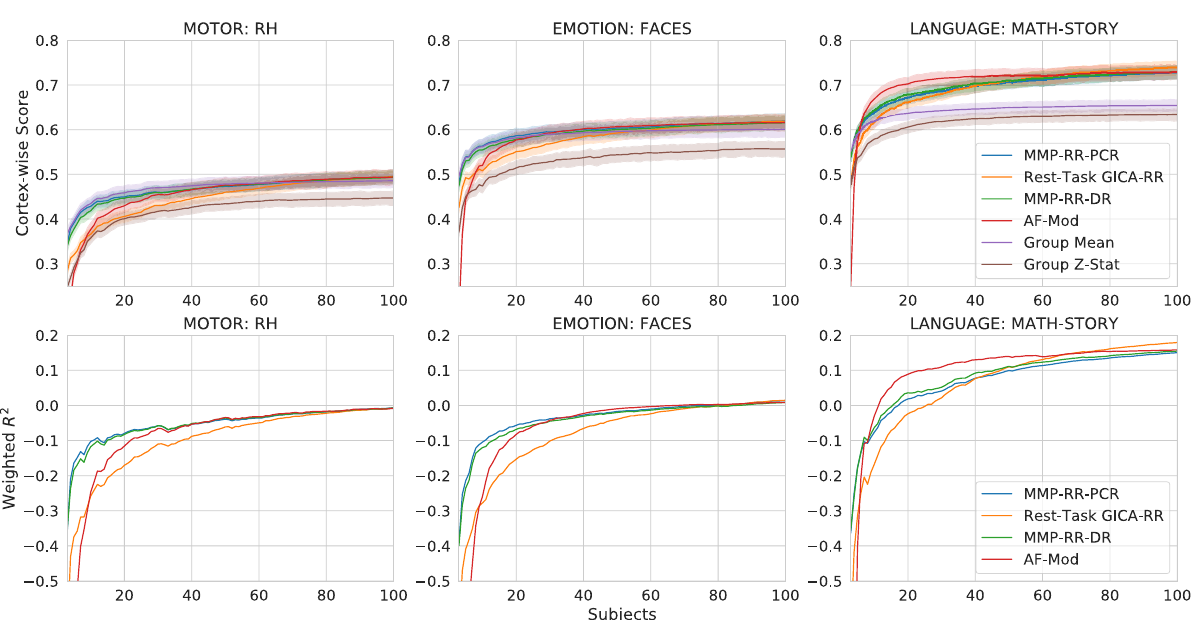
Figure 8. Top row: subject-wise Pearson r score benchmark results for 3 selected (poor, mediocre, good), 4 high performing models ( MMP-RR-PCR , Rest-Task GICA-RR , MMP-RR-DR , AF-Mod ) and two baseline models ( Mean (Baseline) , Group Z-stat ). Poor (left): Motor-Right Hand; Mediocre (middle): Emotion: Faces; Good (right): Language: Math-Story. Experiment included 3–100 subjects for training. The group z-statistic baseline results are considerably worse than the group mean baseline. The 4 models largely resemble each other’s performance when sample sizes increase past 40 subjects. Bottom row: The weighted mean cortical surface R 2 for four top performing models as a function of number of samples (3–100) used for training. As training 2 samples approach over 80 samples, R largely becomes indiscernible between the 4 models in these